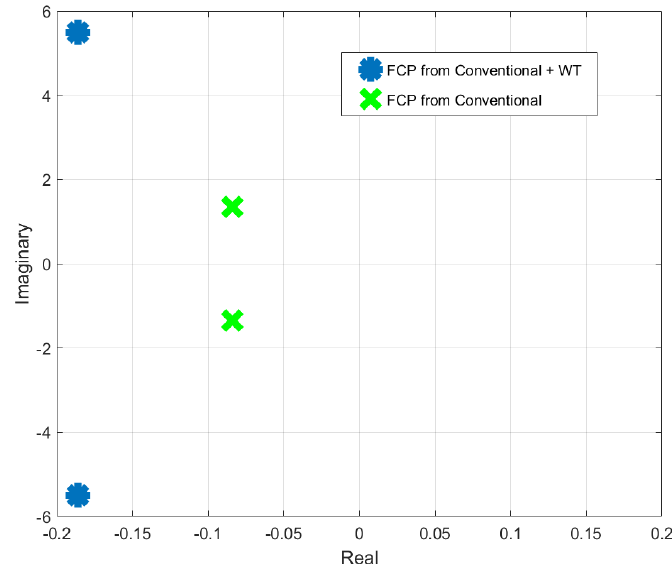
Figure 18. Closed-loop poles for 40% wind